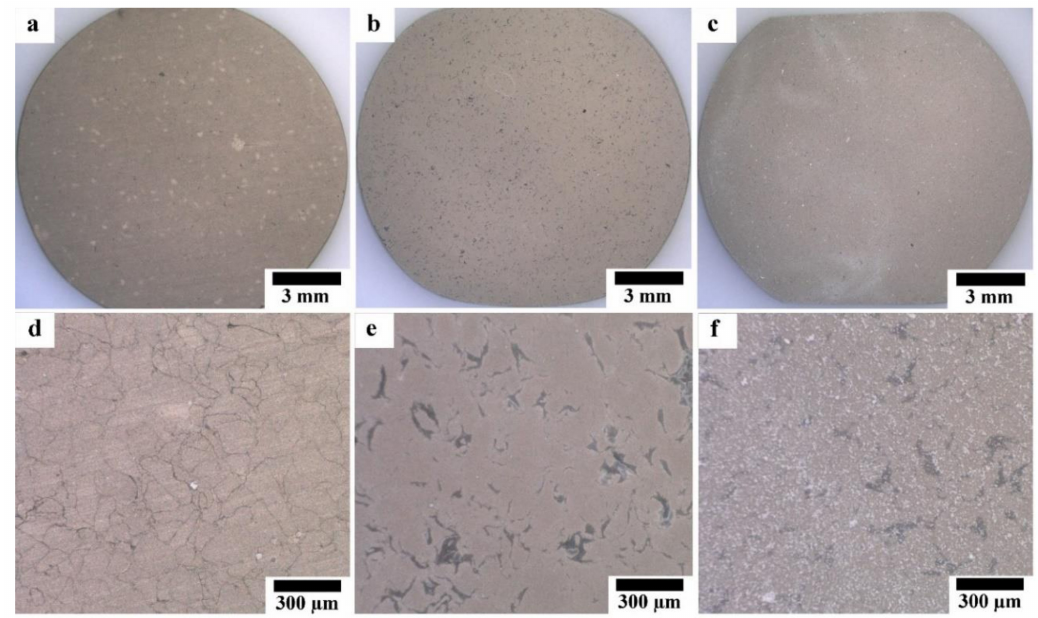
Figure 5. Optical micrographs of HAp-coated samples: ( a , d ) HAp-coated Mg, ( b , e ) HAp-coated Mg-10ZnO-10 min, ( c , f ) HAp-coated Mg-10ZnO-2.5 h + 10